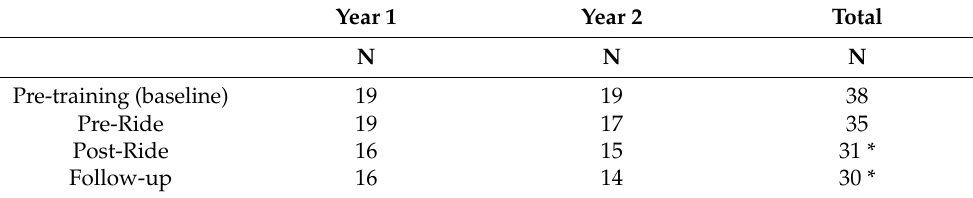
Table 1. Participant sample